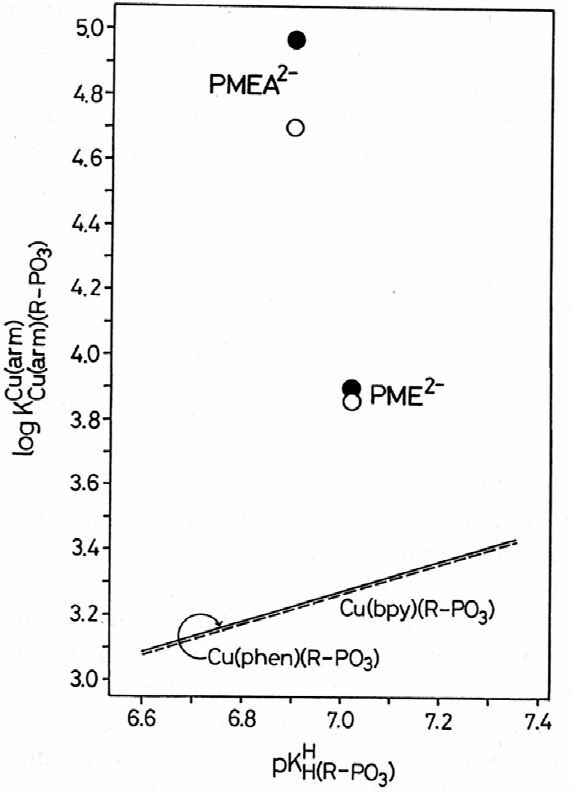
Figure 16. Evidence for an enhanced stability of the Cu(arm)(PME) and Cu(arm)(PMEA) complexes based on the relationship between log K Cu and p K H for the ternary Cu(bpy)(PME) and Cu(bpy)(PMEA) ( ◯ ), as well as for the Cu(phen)(PME) and Cu(phen)(PMEA) ( • ) complexes in aqueous solution at I = 0.1 M (NaNO 3 ) and 25 °C. The plotted data are from Table 6 in Section 8 of [141] (= Table 7 here). The two reference lines represent the log K versus p K a relationship for Cu(arm)(R-PO 3 ) complexes; it should be emphasized that R-PO 32– symbolizes here phosphonates (or phosphate monoesters) with an R group unable to undergo any kind of hydrophobic, stacking, or other type of interaction; the broken line holds for arm = bpy and the solid line for arm = phen. Both straight lines are calculated with the parameters listed in Table 5 of Ref [141], and they represent the situation for ternary complexes without an intramolecular ligand–ligand interaction. Redrawn in a slightly altered way from Ref [141] with permission of the Royal Society of Chemistry and then reproduced with permission from our publication in Coordination Chemistry Reviews [45];